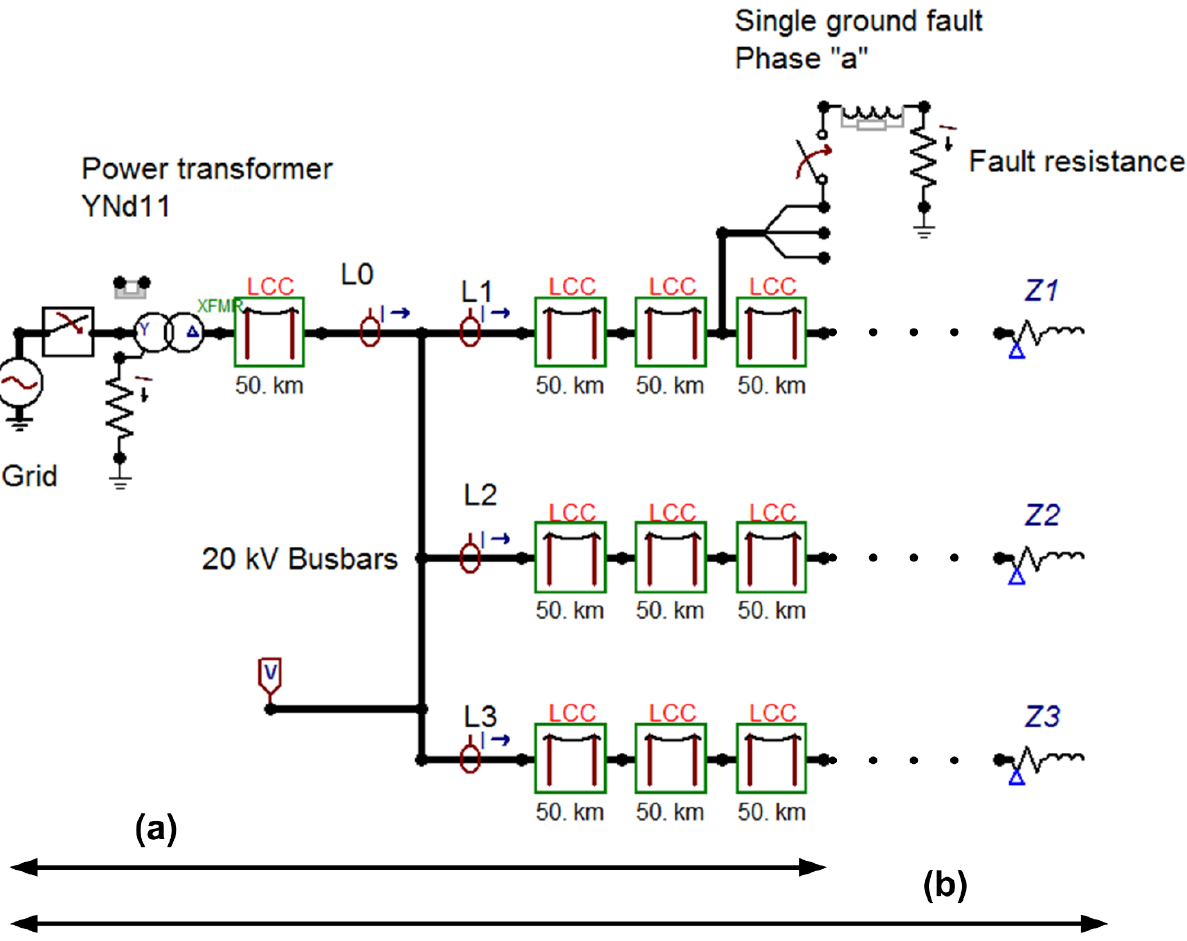
Figure 11. ATP single line diagram for main substation